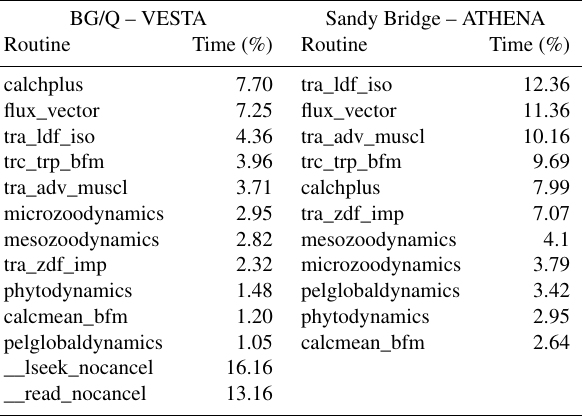
Table 3. Code profiling on BG/Q and Intel Sandy Bridge. The data have been taken with the gprof tool and they refer to the timing of the most computationally loaded process on a run with 2048 pro-